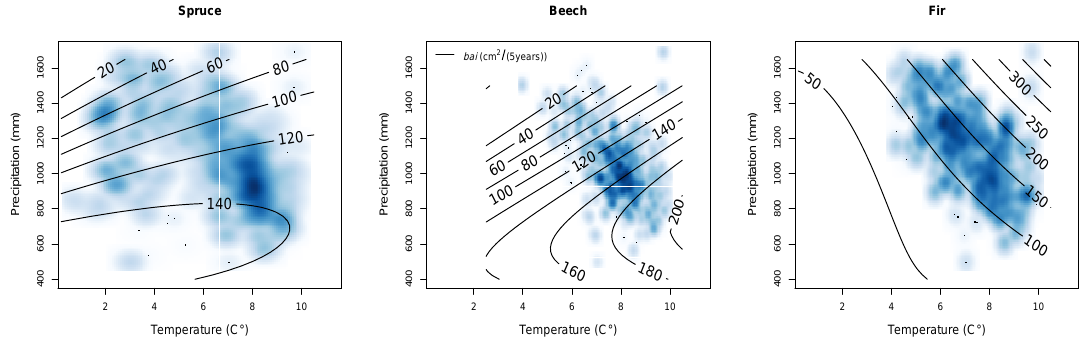
Figure 8. Predicted basal area increment for interacting effects of temperature ( t ) and precipitation ( p ). t and p are mean values over physiological years (see Abbreviations). The blue in the background is the two-dimensional density of the observed t and p . Dark blue contains more data.